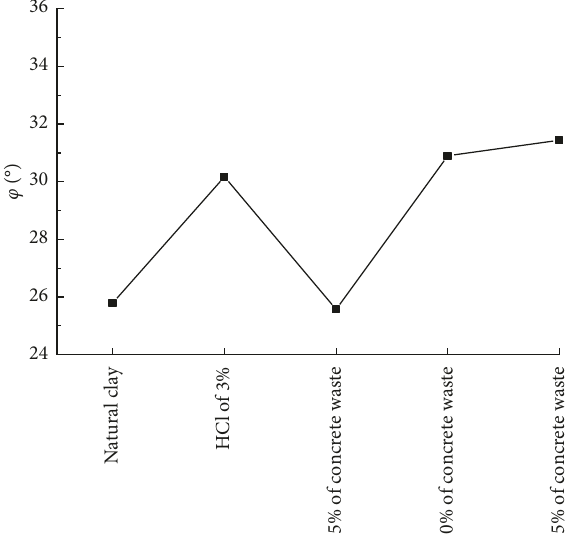
Figure 13: Variation in cohesion of crushed concrete waste-cured acid-contaminated clay.